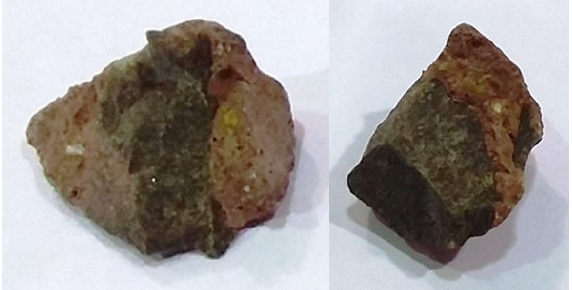
Figure 8. Concretes with 85 MPa comminuted at 19.1 mm (size 4.75/19.1 mm).